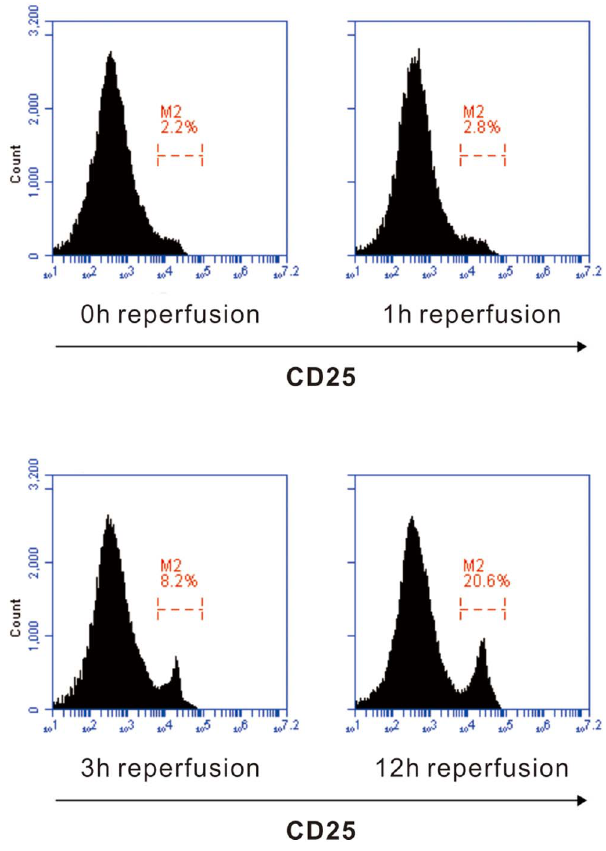
Figure 1. Detection of CD4 + T cell activation by up-regulation of CD25. After partial ischemia and 0, 1, 6, 12 hours reperfusion, CD4 + T cells were gated, and the proportion of CD4 + CD25 + T cells were quantitated by FACS. doi:10.1371/journal.pone.0106892.g001 PLOS ONE |